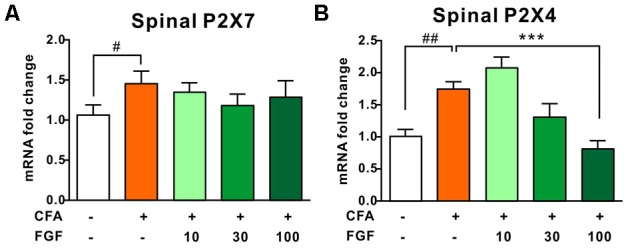
FGF down-regulated the spinal P2X4 mRNA level post-CFA injection, but did not affect P2X7 mRNA transcription. The spinal P2X7 (A) and P2X4 (B) mRNA levels in the L4–L6 spinal segments were analyzed by real-time PCR. All data are normalized to controls. One-way ANOVA and Bonferroni multiple comparison tests as post hoc analyses were used (n = 7 per group). #, ## vs. controls and ∗, ∗∗, ∗∗∗ vs. CFA-treated animals. One symbol, p < 0.05; two symbols, p < 0.01; three symbols, p < 0.001.